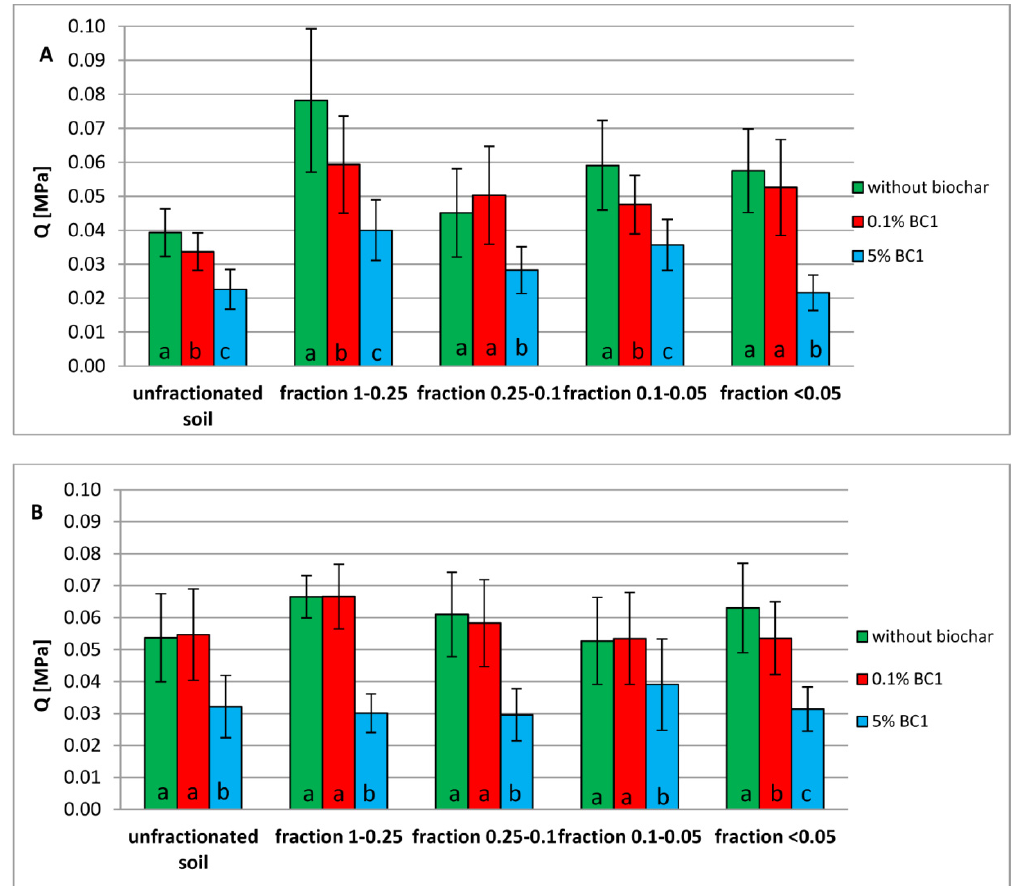
Figure 9. Wood waste biochar (BC1) effect on the tensile strength of air-dried ( A ) and wetted ( B ) cylinders formed from the unfractionated soil and its selected fractions ; the bars correspond to the standard deviation.